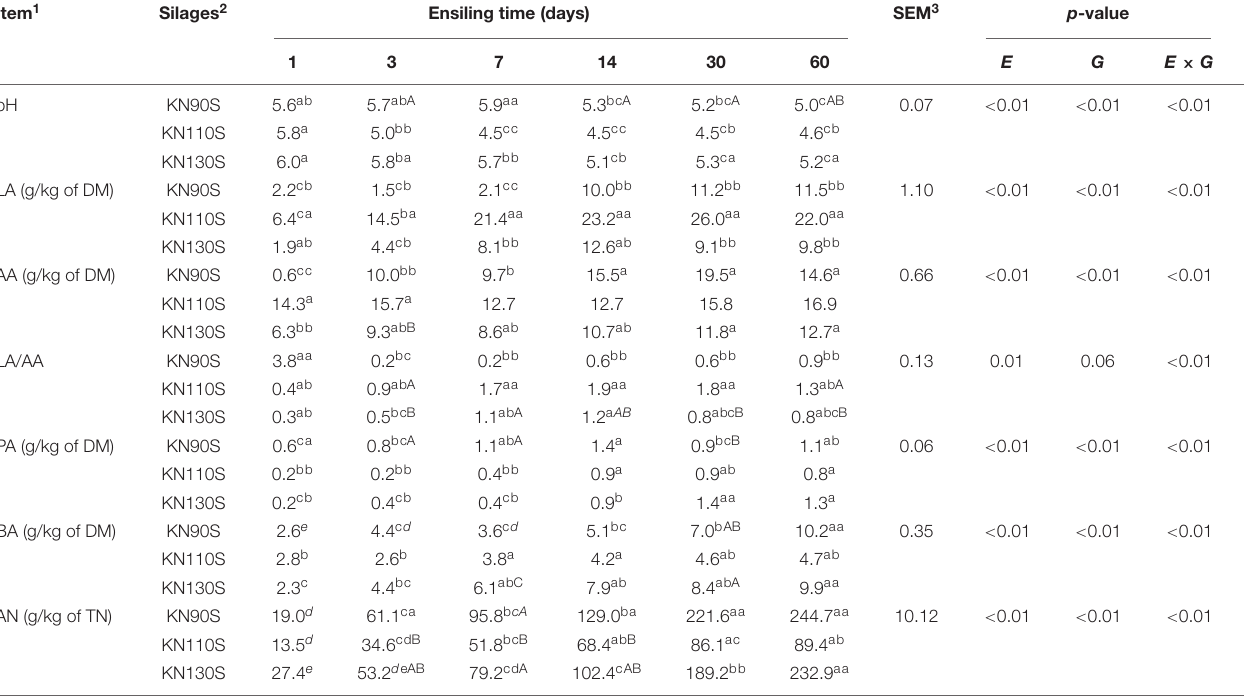
TABLE 3 | Changes in the fermentation quality of king grass silage during